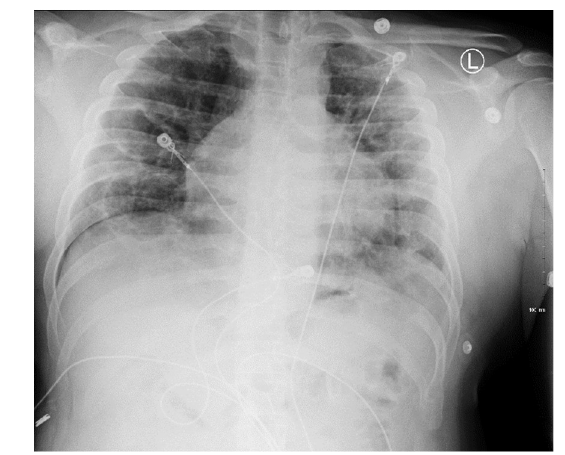
Figure 2. Follow up chest x-ray on Day 4 showing an unresolved right pneumothorax (20-30%) and ill-defined pulmonary opacities throughout both lungs, deduced to be bilateral interstitial disease. A round lesion with central air-fluid levels formed within the right mid lung and was speculated to be a